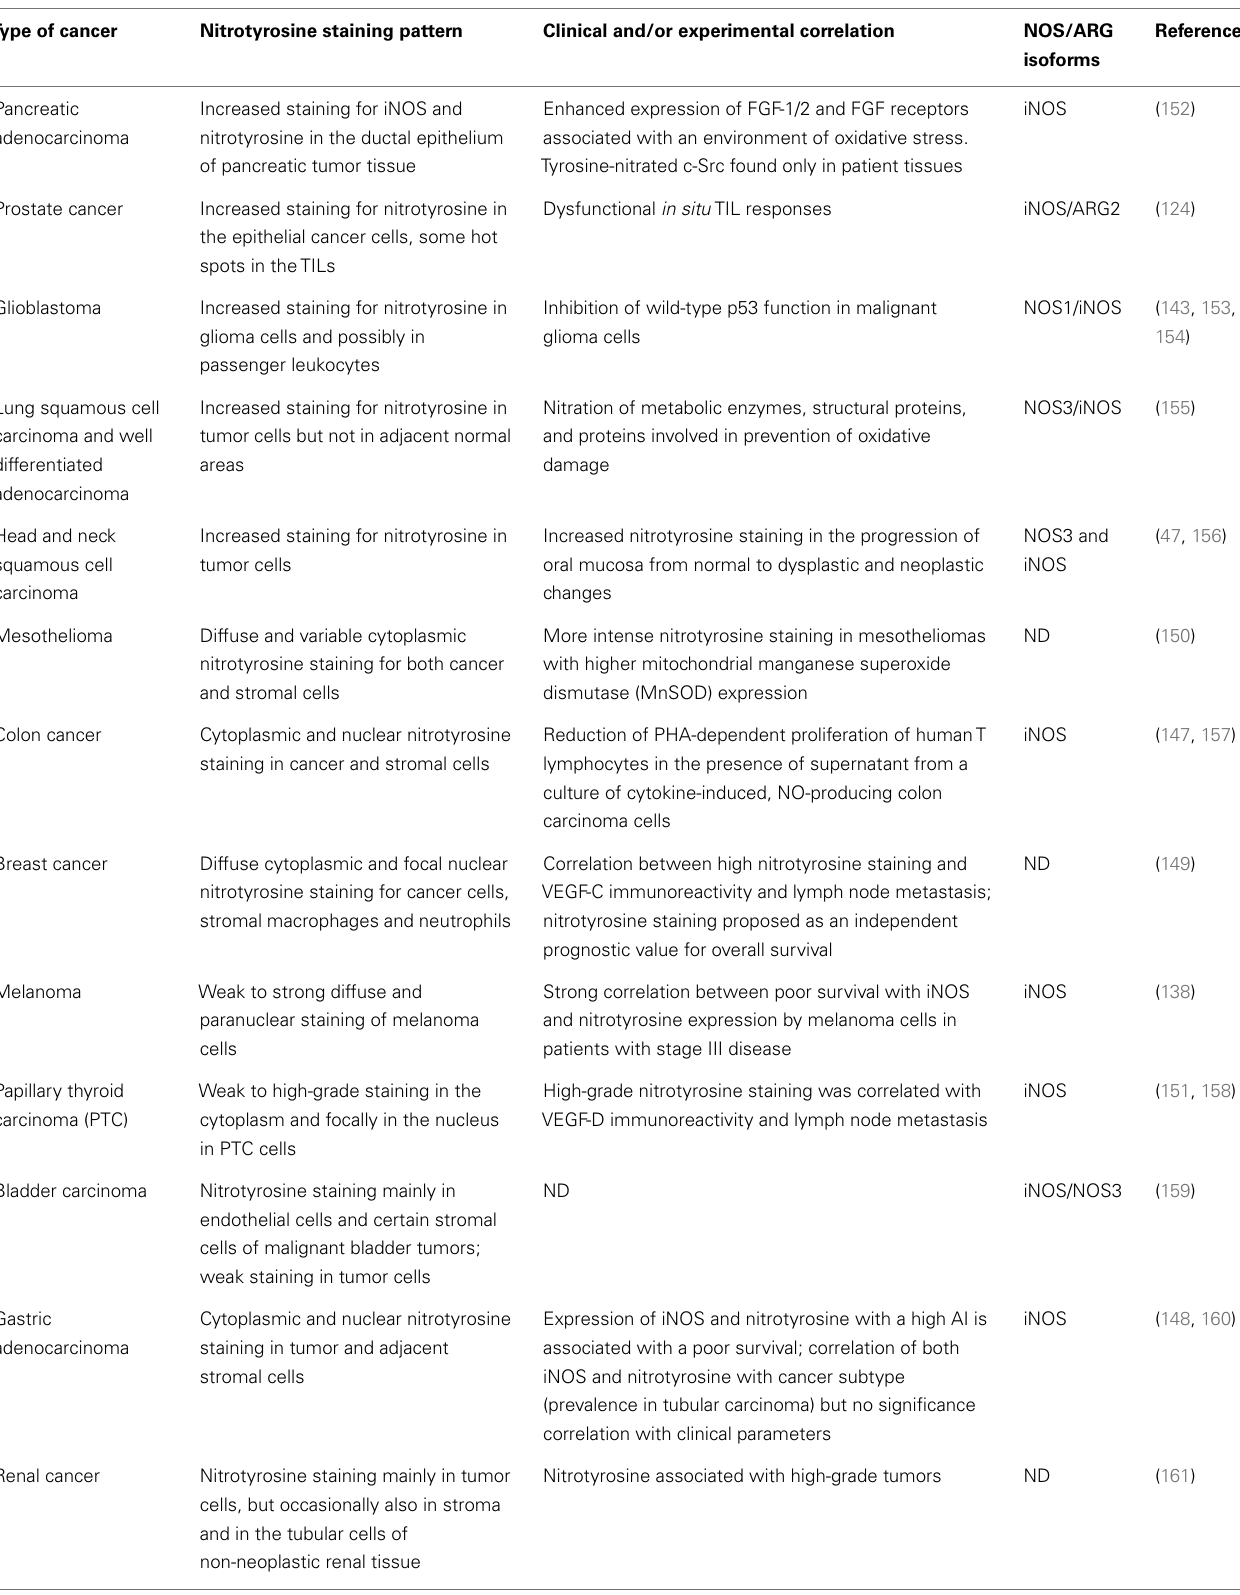
Table 1 | Nitrotyrosine presence in human